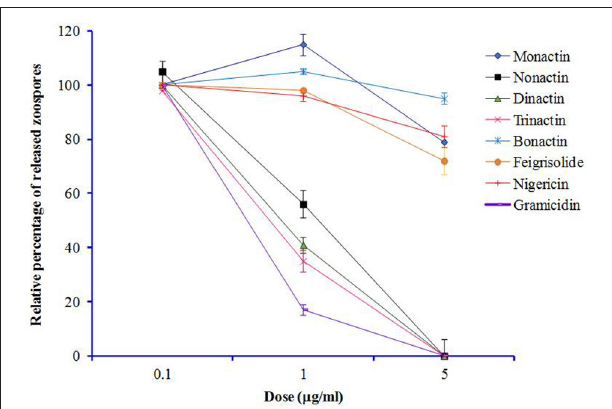
FIGURE 5 | Effects of macrotetrolide antibiotics, and bonactin, feigrisolide C, nigericin and gramicidin on relative percentage (%) of release of zoospores from sporangia (zoosporogenesis) of grapevine downy mildew pathogen Plasmopara viticola over untreated control ( p ≤